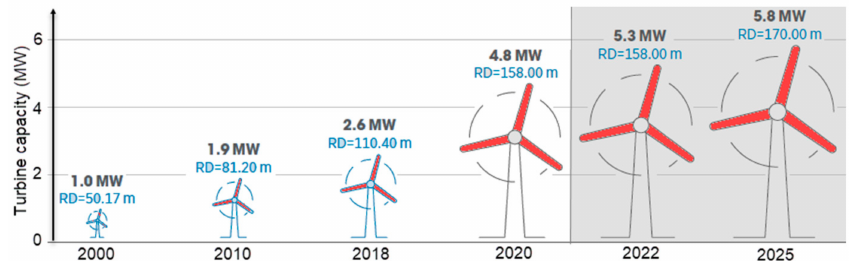
Figure 3. Power and rotor diameters of existing and planned onshore wind farms [2].